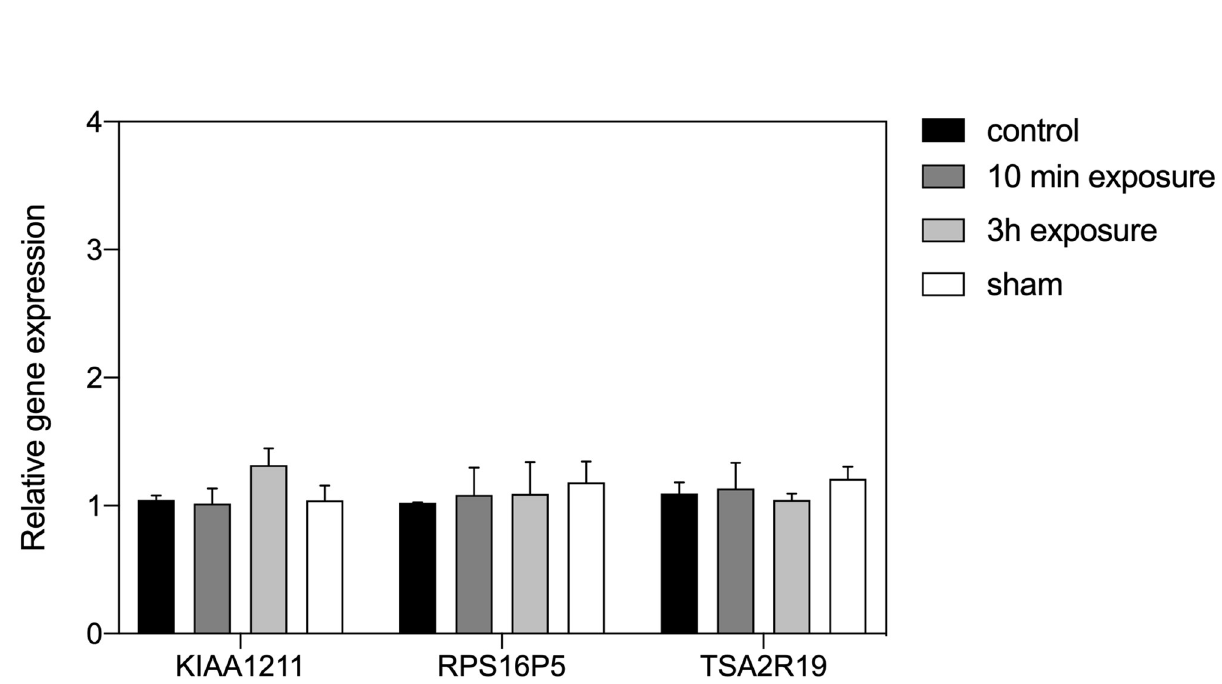
Fig 2. Effect of a 500 μ T static magnetic field on HEK293 gene expression. The results are presented as the expression level of genes KIAA1211, RPS16P5 and TAS2R19 after exposure to 500 μ T condition for 10 min (dark-grey bar) or 3h (light-grey bay) in comparison to the Control (black bar) or sham-exposed (white bar) condition. The ‘Control’ condition is the local geomagnetic field in the incubator. The ‘Sham’ condition uses a Helmholtz coil with current running in antiparallel directions to cancel the induced magnetic field (see Methods). Data are shown as mean ± SE of three independent experiments (N = 3). The asterisks indicate significance level of the differences: � p -value < 0.1; �� p -value < 0.01; ��� p -value < 0.01. https://doi.org/10.1371/journal.pone.0243038.g002 PLOS ONE | https://doi.org/10.1371/journal.pone.0243038 December3,